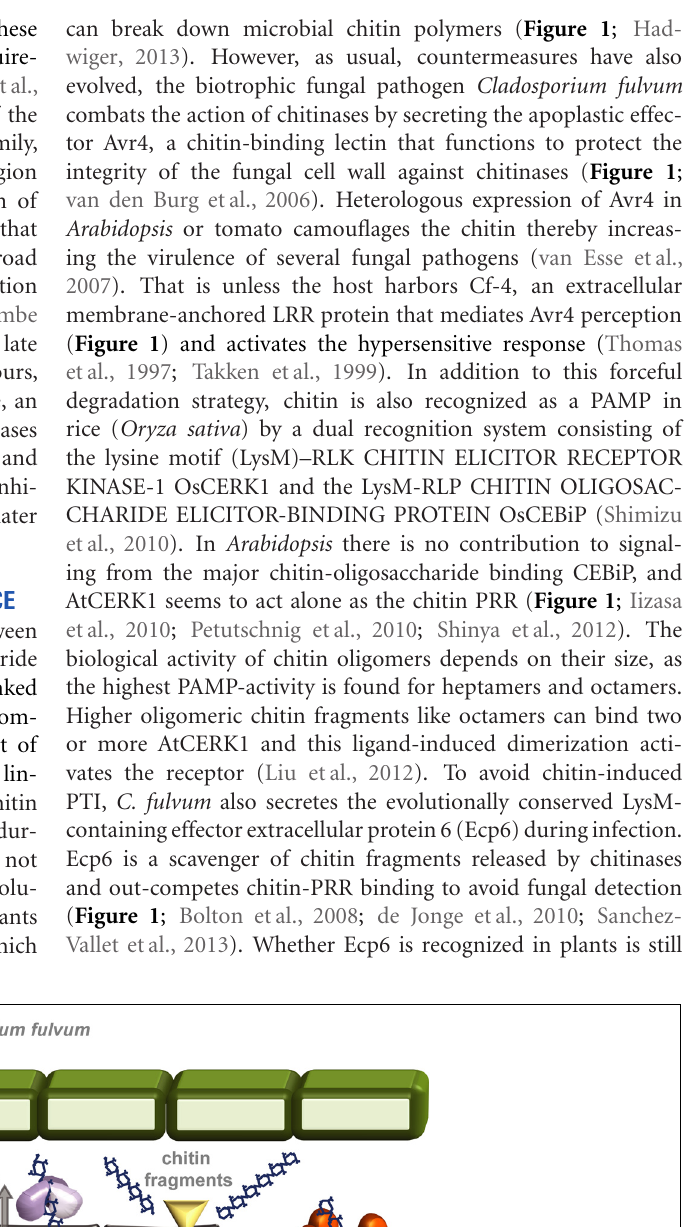
recognized by theTomato RLP Cf-4, leading to induction of the hypersensitive response (Thomas etal., 1997;Takken etal., 1999). Chitin oligomers released by chitinases are recognized as PAMPs, in Arabidopsis by the RLK CERK1 (Iizasa etal., 2010; Petutschnig etal., 2010), and in rice by both OsCERK1 and the RLP OsCEBiP (Shimizu etal., 2010).To escape chitin-induced PTI C. fulvum can secrete Ecp6 an effector that functions as a chitin-scavenger removing the chitin oligomers released by the chitinases (de Jonge etal., 2010; Kombrink andThomma, 2013; Sanchez-Vallet etal.,